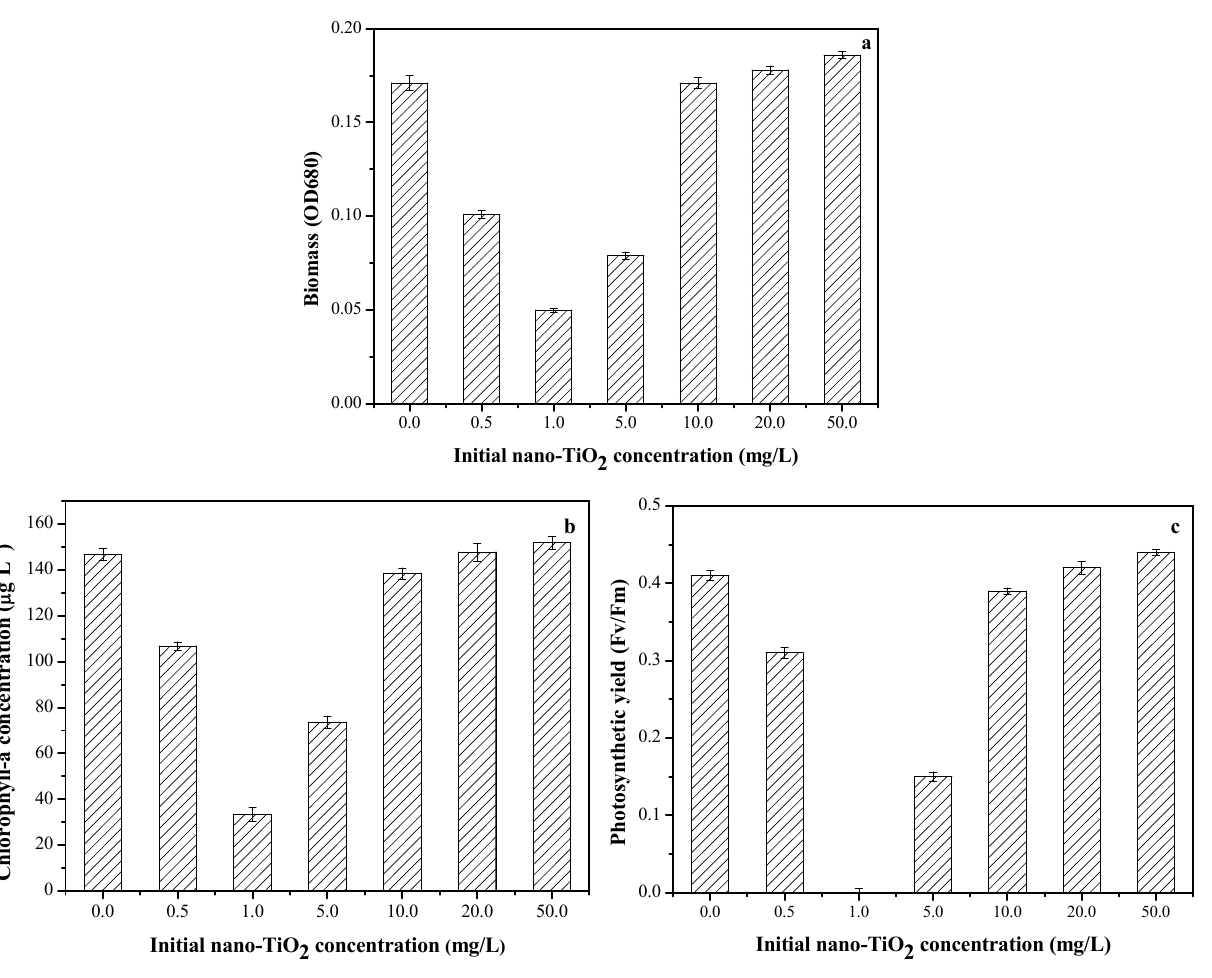
Figure 7. Toxic effect of Nano-TiO on the inhibition of Anabaena sp. with the fixed Zn 2+ 2 ; ( b ) Chlorophyll-a at 96 h. ( a ) Biomass of algae at different initial level of nano-TiO 2 concentration at different level of nano-TiO ; ( c ) Photosynthetic yield of algae at different 2 initial level of nano-TiO 2